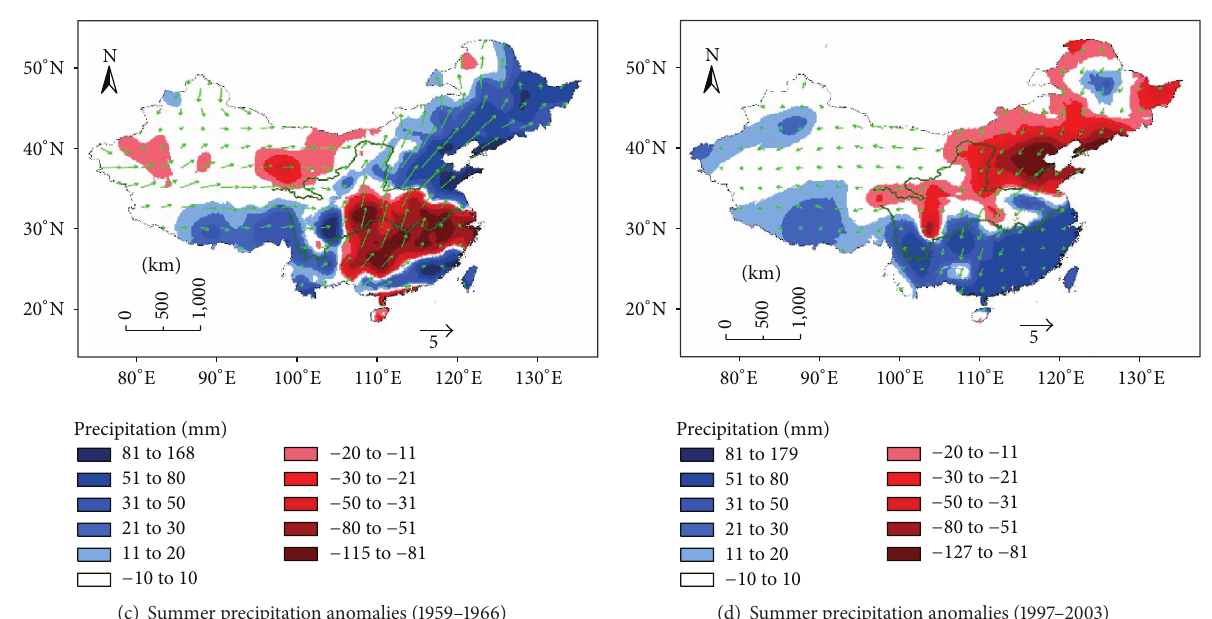
all of China is controlled by negative geopotential anomalies while positive geopotential anomalies appear for the PSC- DNC